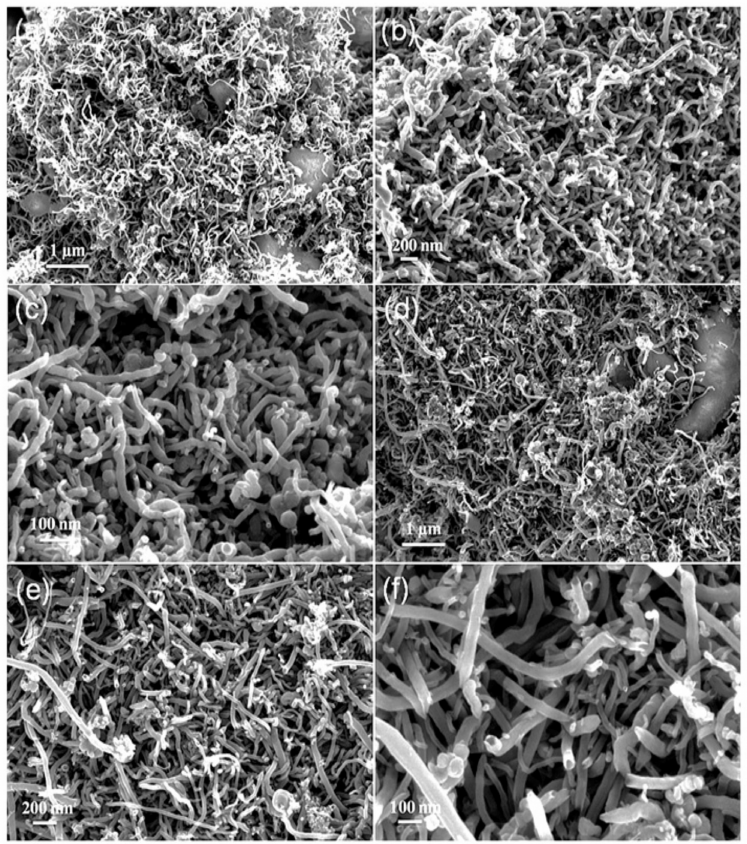
Figure 6. FE-SEM images of nanocarbon deposited over ( a – c ) Ni-Co/SBA-15 and ( d – f ) Ni-Fe/SBA-15; reprinted with permission from ref. [54]. Copyright 2015